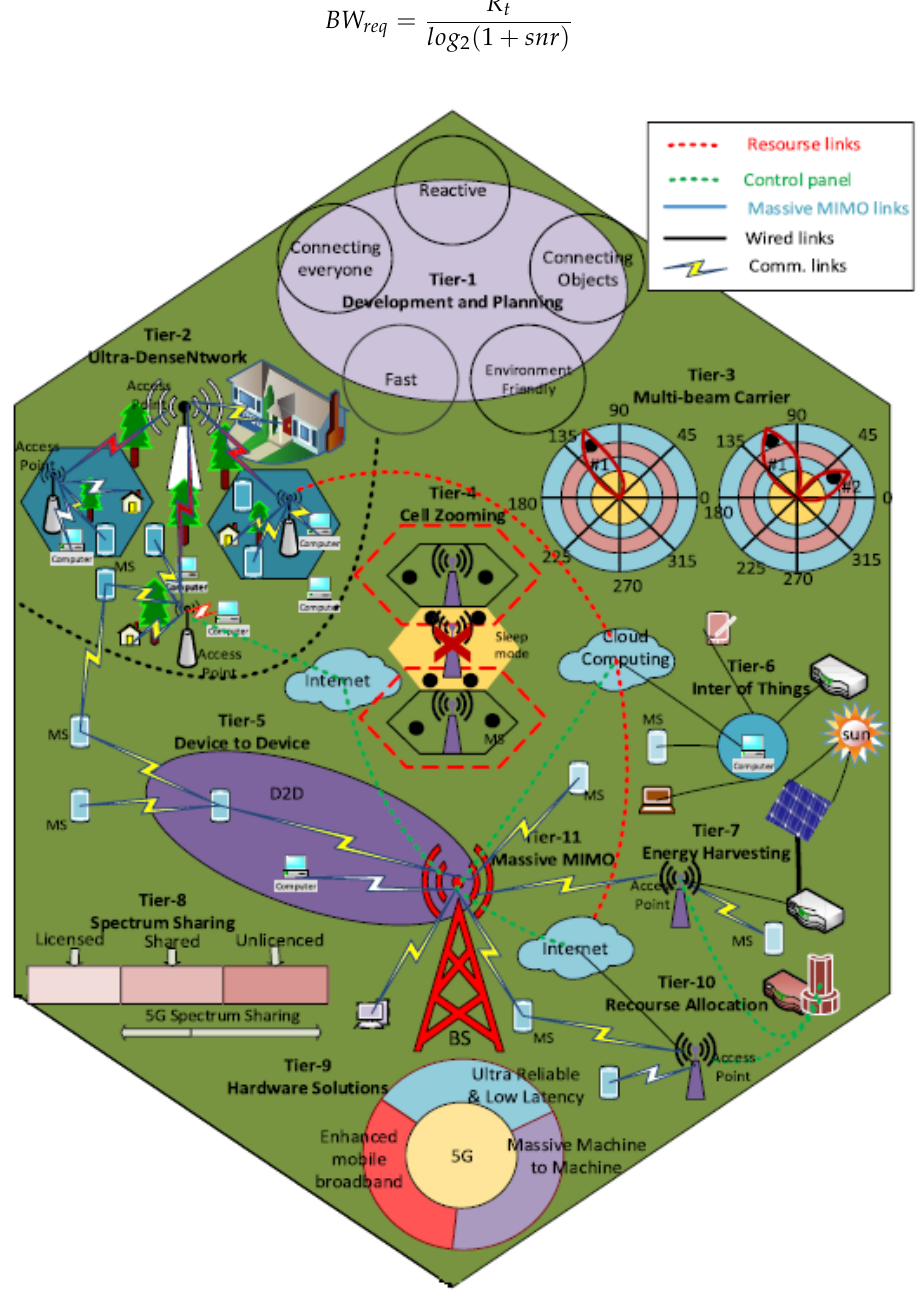
Figure 1. Multi-tier architecture for energy efficient 5G networks